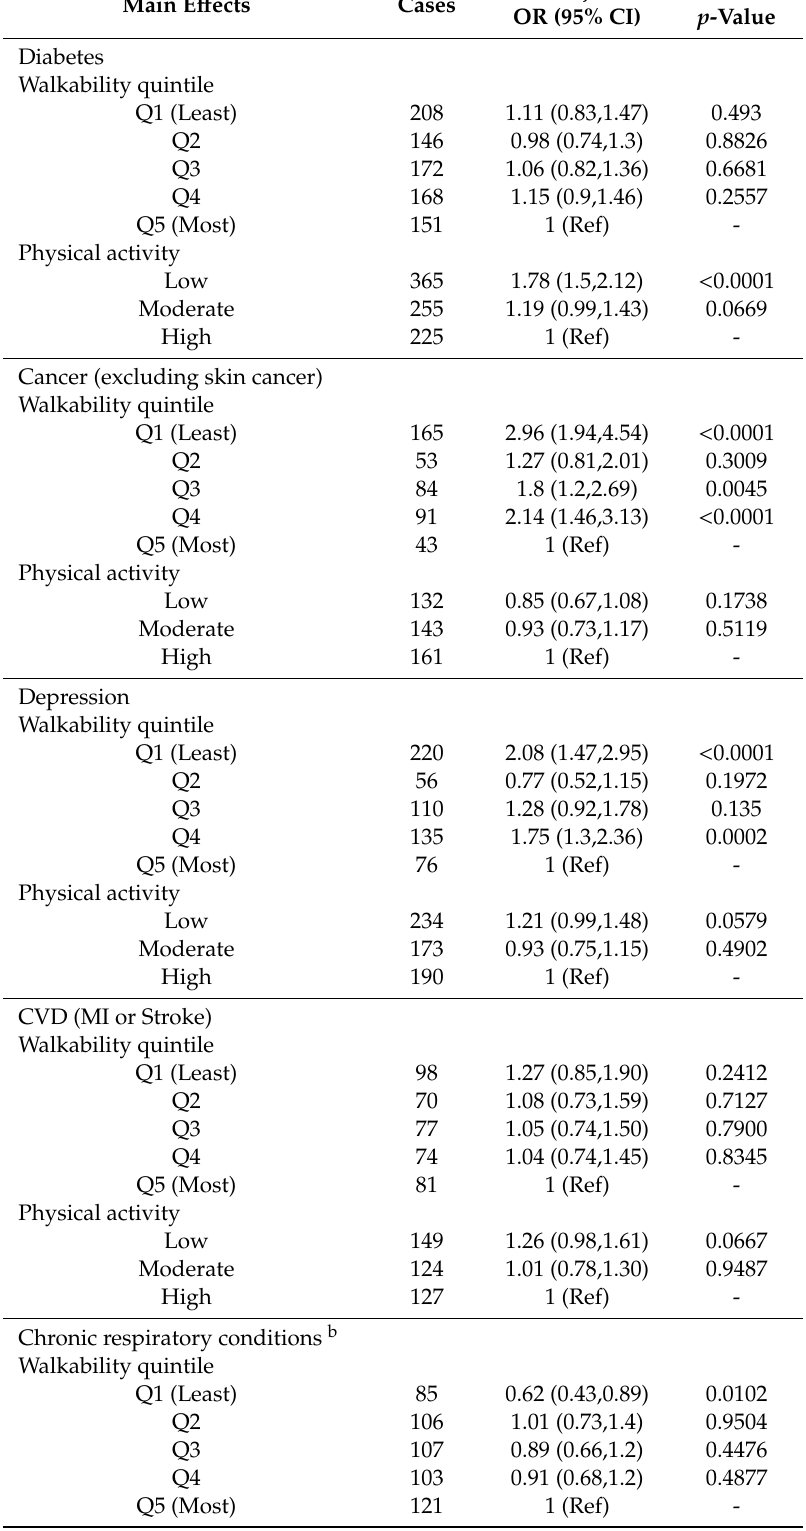
Table 2. Associations of walkability and physical activity with selected chronic conditions and multi-morbidity at